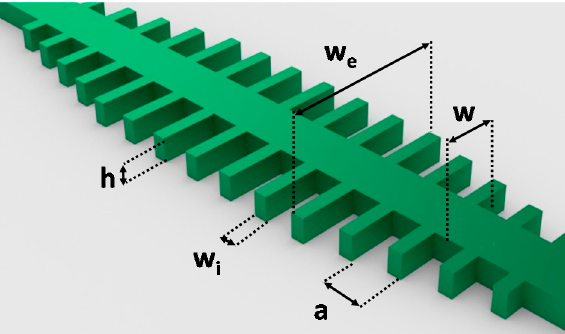
Figure 4. Schematic representation of the PBG sensing structure and its structural parameters.